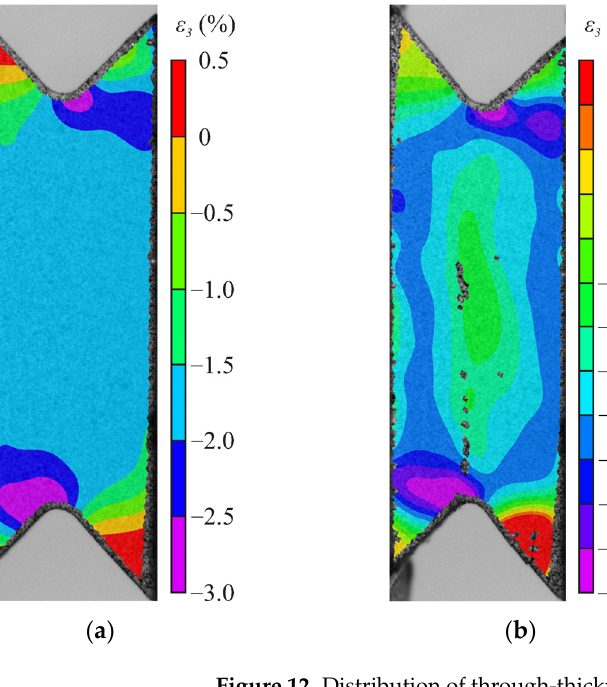
Figure 13. Distribution of shear strain at maximum load: ( a ) on the face surface at α = 20°, ( b ) on the face surface at α = 45°, ( c ) between the notches.